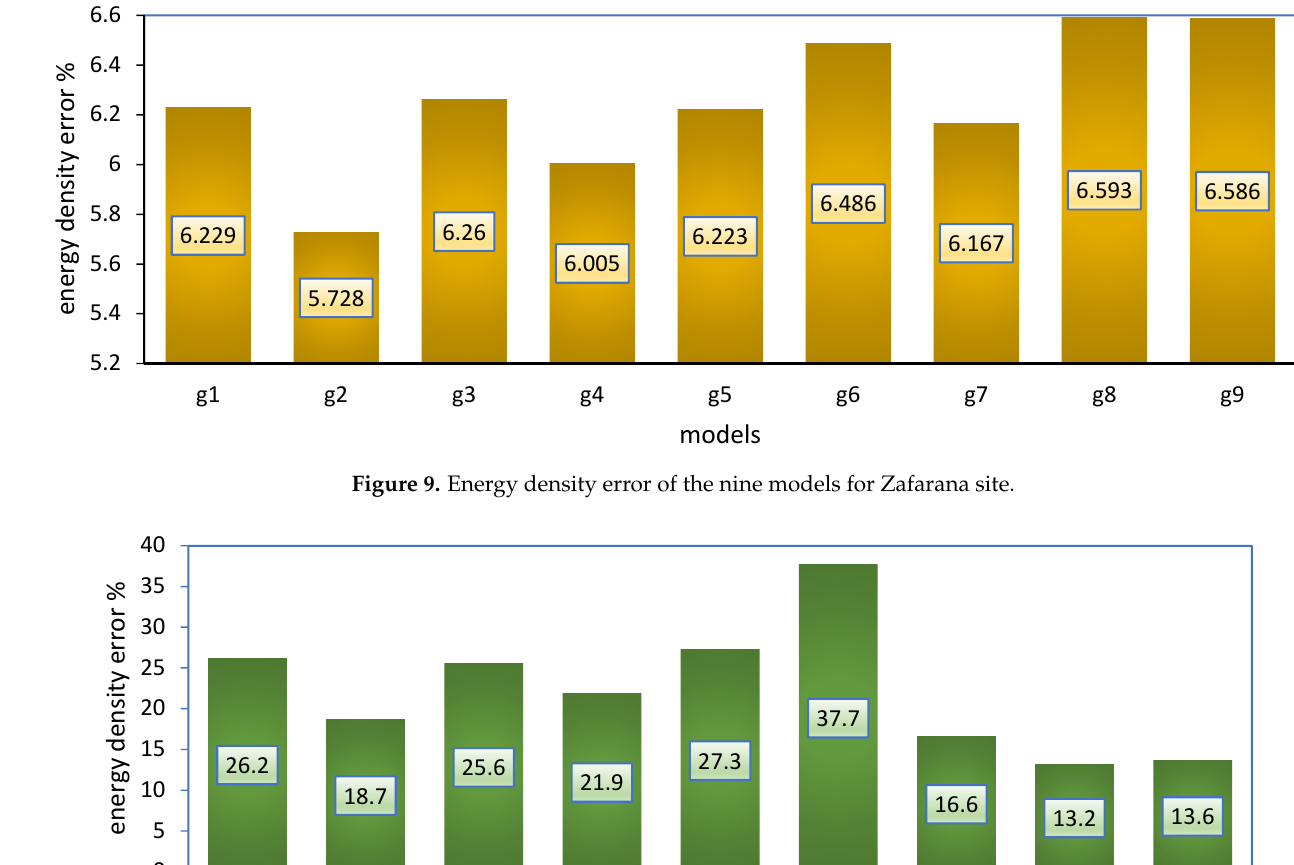
15 Figure 8. Typical wind turbine power curve. The error of energy density results for two sites is calculated where the distributions of energy density error for the nine models are shown in Figures 9 and 10 for the Zafarana and Shark El-Ouinate sites, respectively. From Figure 9, at the Zafarana site, the second model ( g 2 ) provides the minimum error of energy density of 5.728%. After that, the fourth ( g 4 ) and seventh ( g 7 ) models come with an error of energy density of 6.005 and 6.167%,